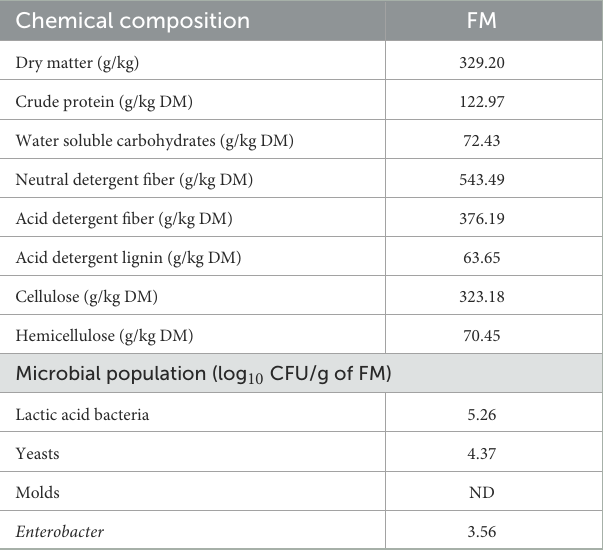
TABLE 1 Chemical composition and microbial population before